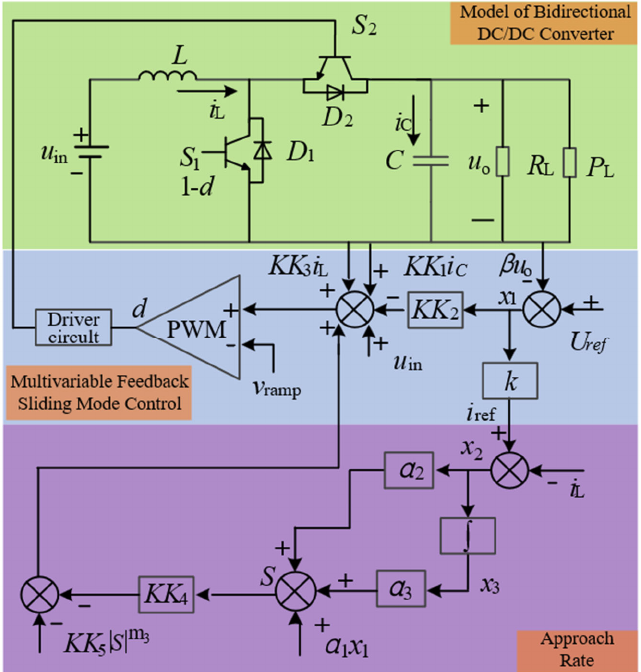
Figure 4. Multivariable ‐ feedback sliding ‐ mode control of bidirectional DC/DC converter.